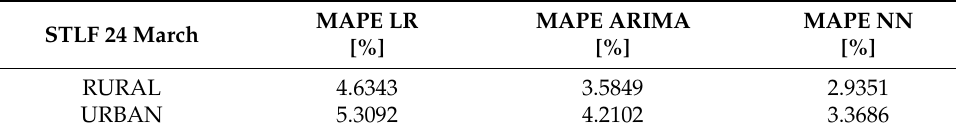
Table 1. MAPE results using the unaltered STLF algorithm.